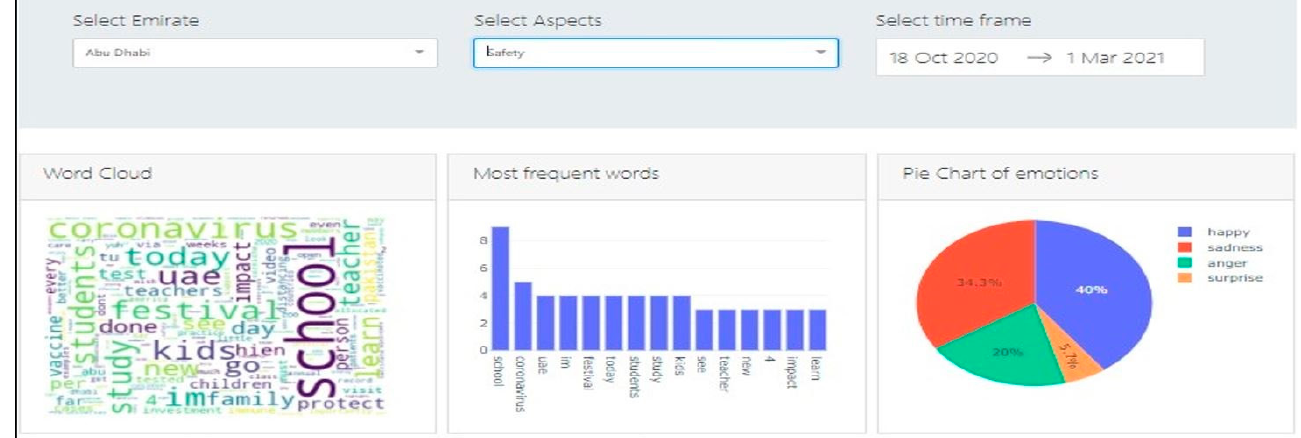
Figure 12. Testing Scenario#2.